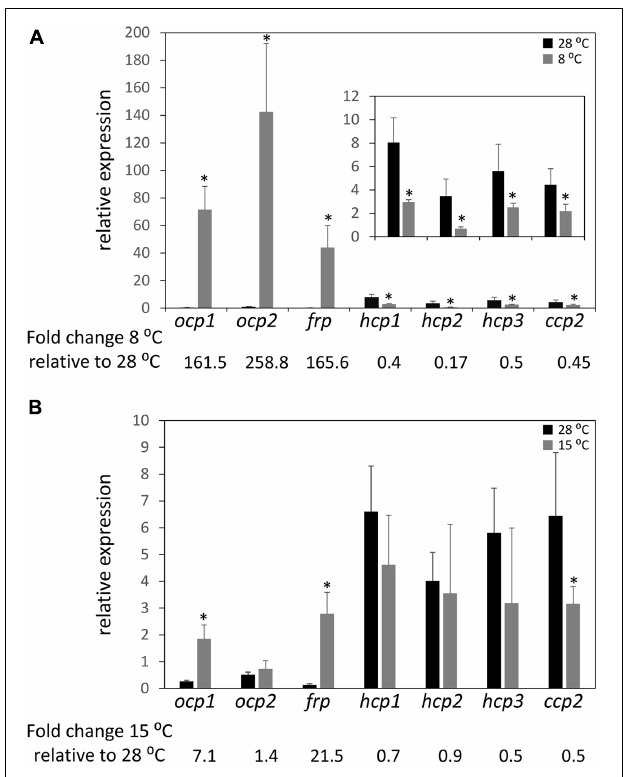
FIGURE 3 | Cold-dependent expression of ocp homologs. Relative expression of ocp1 , ocp2 , frp , hcp1 , hcp2 , hcp3 , and ccp2 were measured using qPCR, comparing samples incubated for 24 h at (A) 8 ◦ C or (B) 15 ◦ C to control samples maintained at 28 ◦ C ( ± SD, n = 6). ∗ p < 0.05 as determined by a two tailed Student’s t -test for the comparison of the treated and untreated